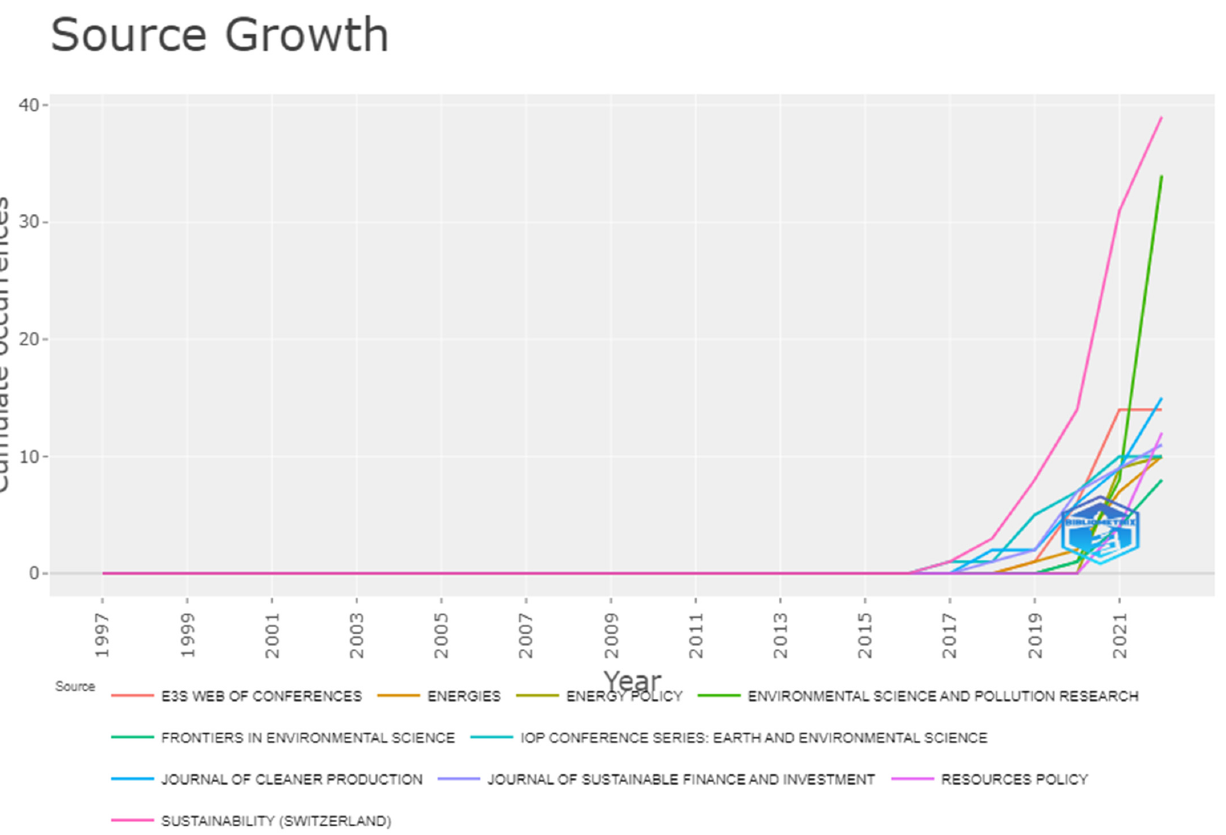
Figure 7. Source growth over